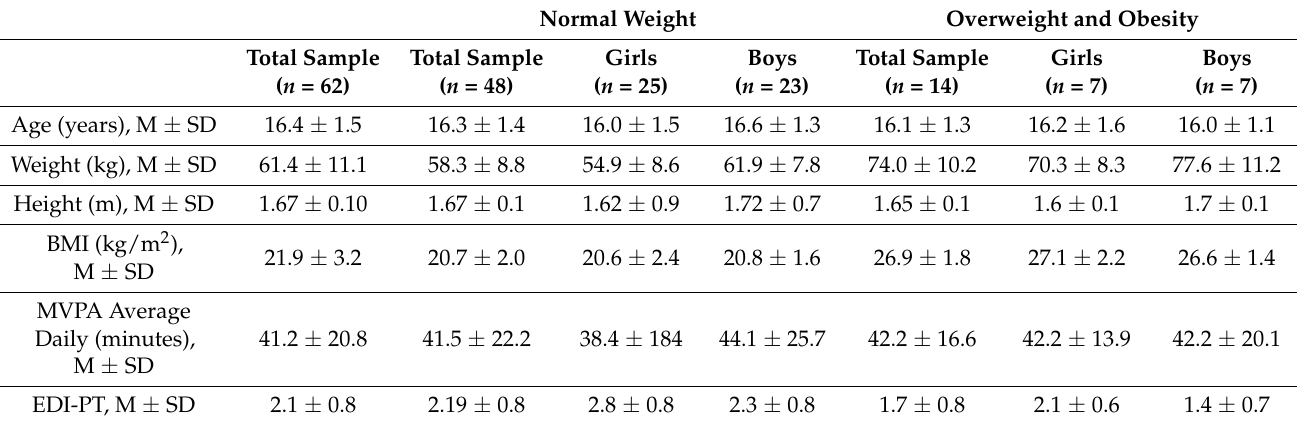
Table 1. Sample characteristics. Normal Weight Overweight and